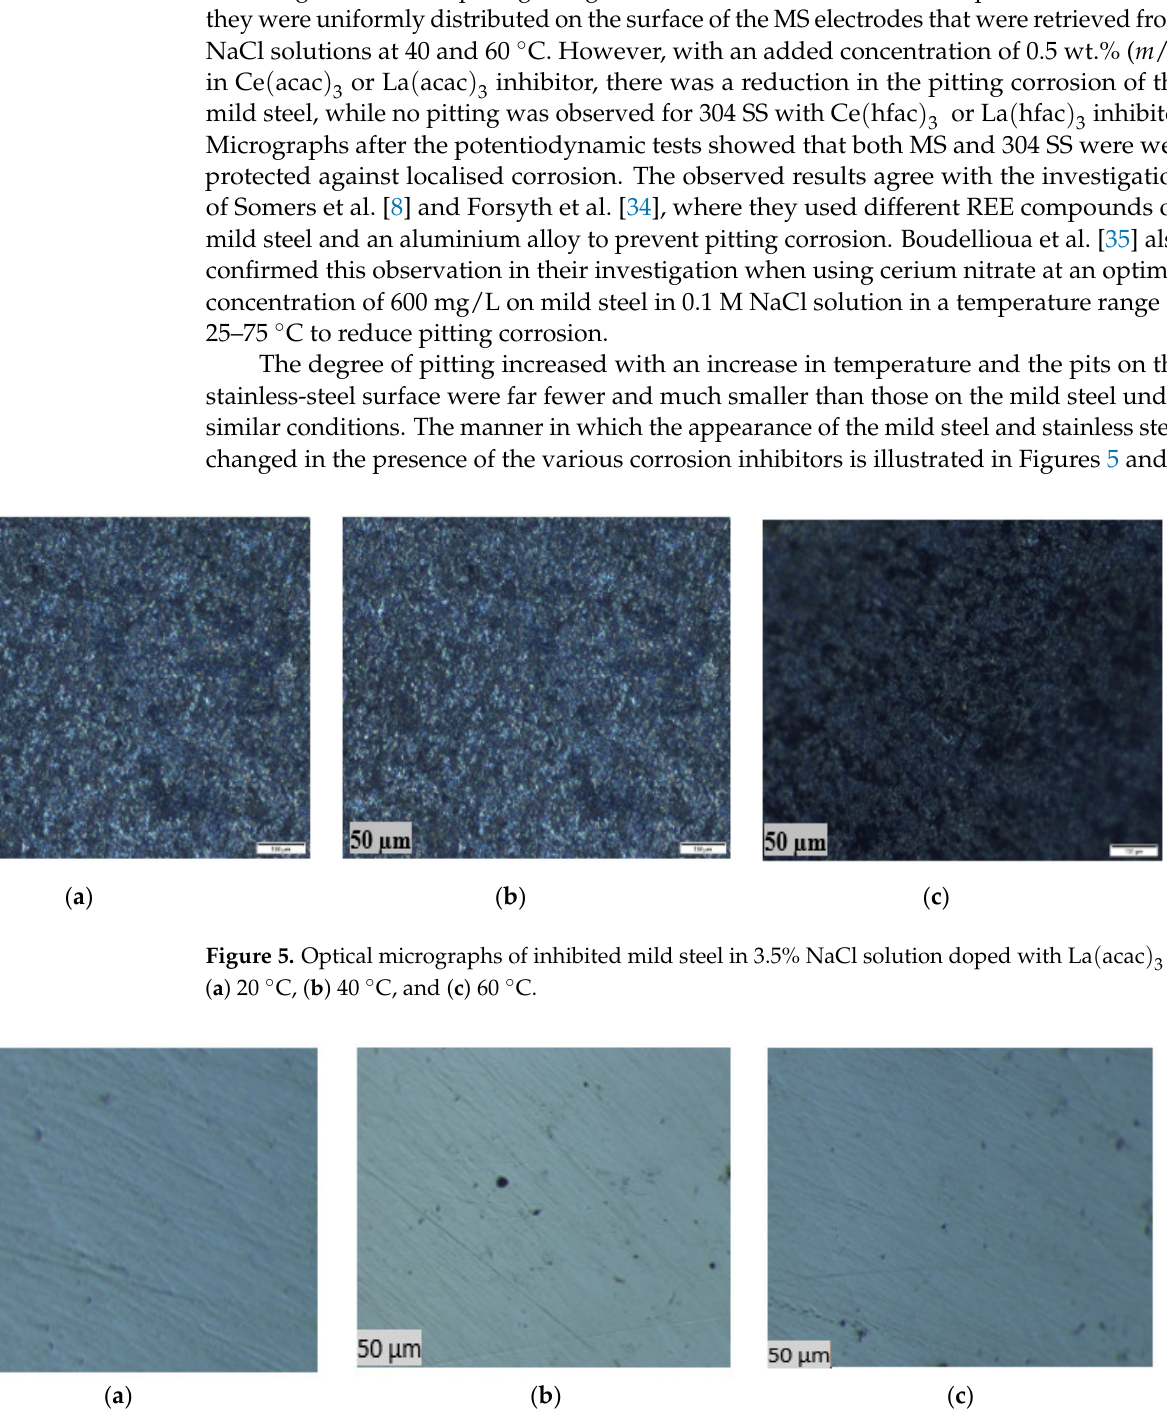
at ( a ) Ce(hfac) (cid:5) 3